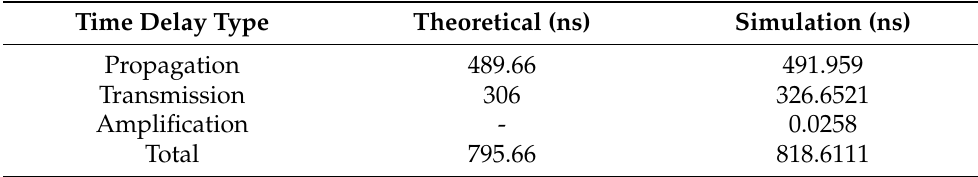
Table 7. Time delays from 32-bits sensors to